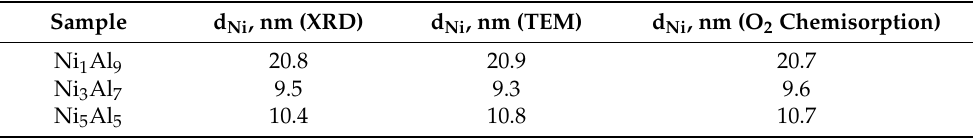
Table 1. Ni crystallite size determined by X-ray diffraction (XRD), transition electron microscopy (TEM), and O 2 chemisorption of the NiAl 2 O 4 catalysts with various Ni/Al ratios (after reduction).